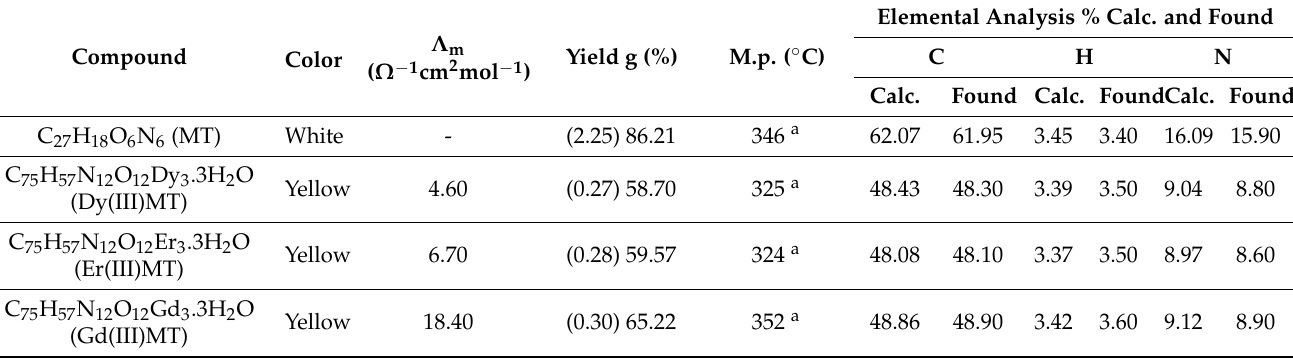
Table 1. Elemental and physical data of 2,4,6-Tris(4-carboxybenzimino)-1,3,5-triazine(MT) and its Ln(III) complexes. Λ m Compound Color Yield g (%) M.p. ( ◦ ( Ω − 1 cm 2 mol − 1 )